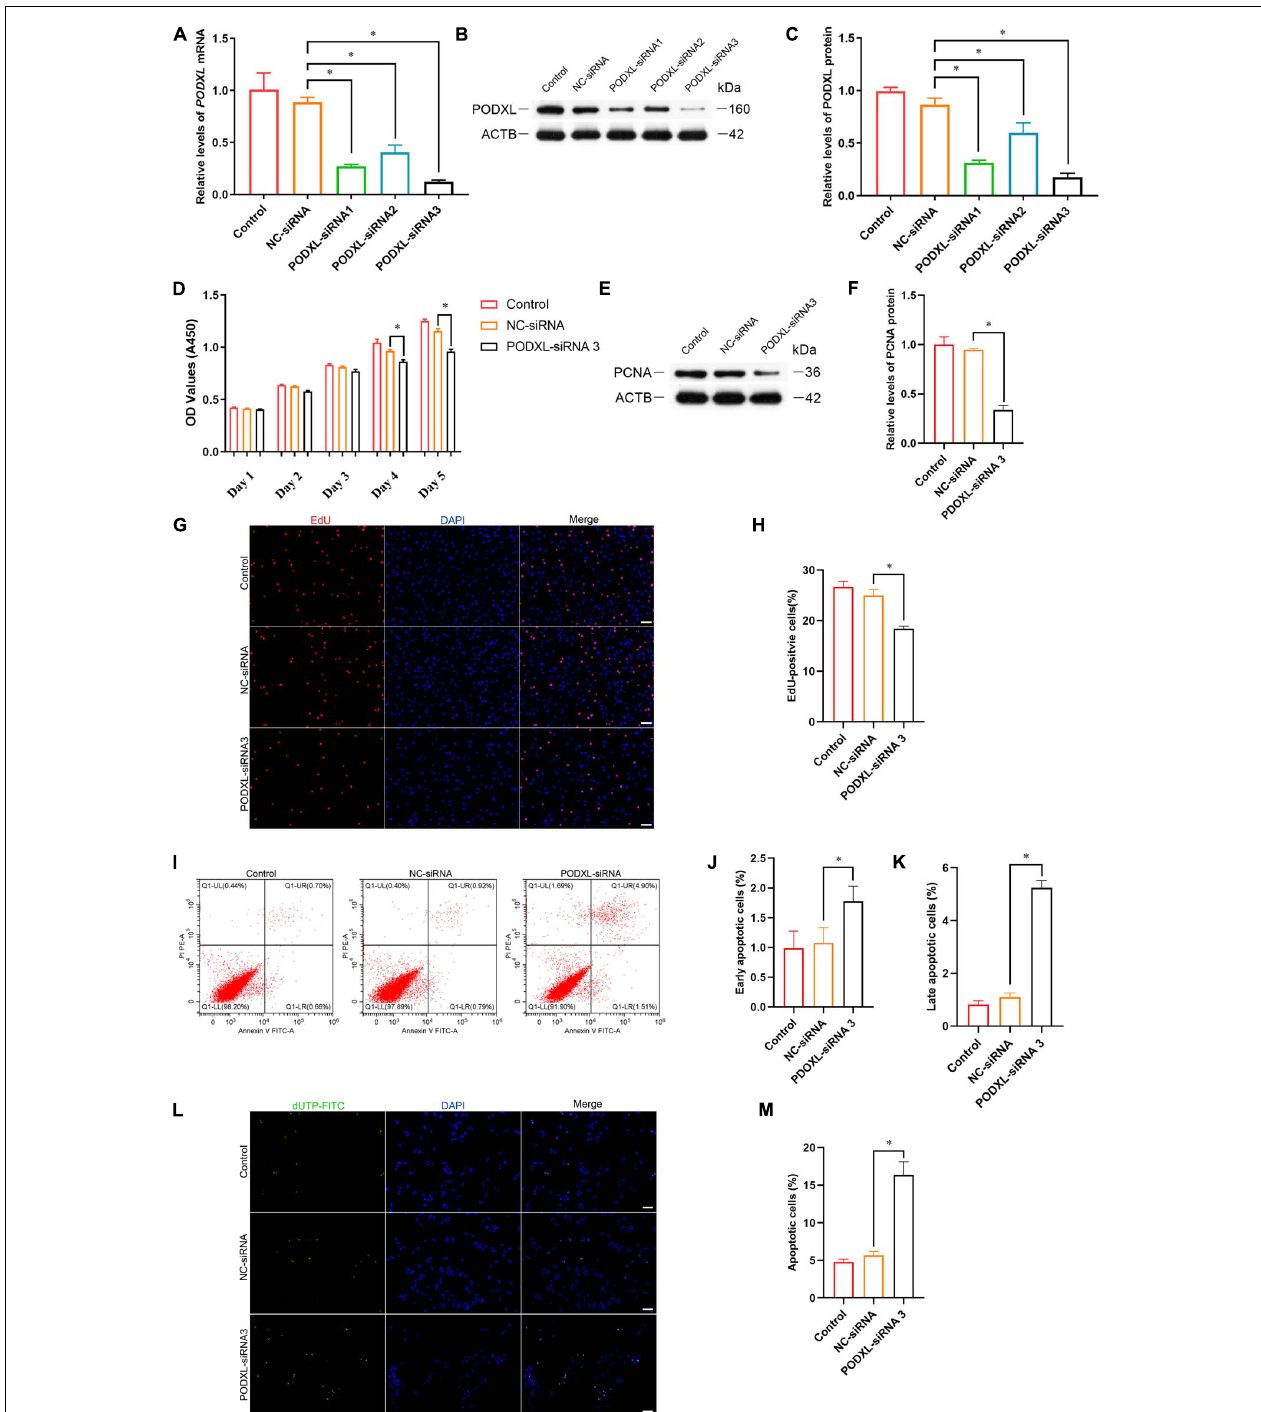
FIGURE 6 | The effect of PODXL knockdown on the proliferation and apoptosis of the human SSC line. (A) qPCR assessment of PODXL mRNA in the human SSC line transfection with TCF3-siRNA 1-, 2-, and 3. ACTB was used for the normalization. (B,C) Western blotting showed PODXL proteins in the human SSC line by the PODXL-siRNA 1-, 2-, and 3 treatment. (D) CCK-8 assay illustrated the proliferation of in the human SSC line by NC-siRNA and PDOXL-siRNA3 treatment. (E,F) Western blotting revealed the PCNA protein levels in the human SSC line by the PODXL-siRNA 3 and NC-siRNA transfection. (G,H) EdU assays of DNA synthesis in the human SSC line with the NC-siRNA and PODXL-siRNA3 transfection. (I–K) Flow cytometric and APC Annexin V analysis of the proportions of early and late apoptosis in the human SSC line with the NC-siRNA and PODXL-siRNA3 transfection. (L,M) TUNEL assay of the fractions of TUNEL + cells in the human SSC line affected by the NC-siRNA and PODXL-siRNA3. Scale bars: (G,L) , 50 µ m. ∗ p < 0.05 denoted the significant differences between PODXL-siRNA 3 and NC-siRNA.